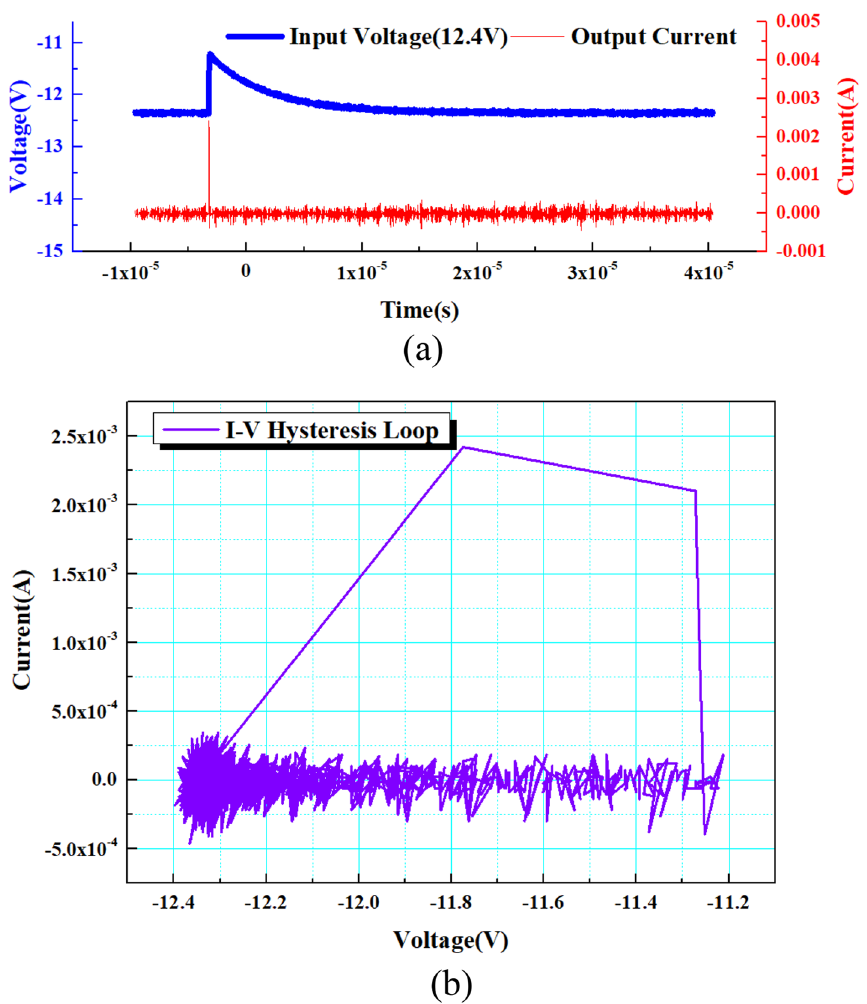
Figure 9. ( a ) Test voltage–time curve and test current–time curve of VADTS under the excitation of pulse signal. ( b ) Test hysteresis loop of